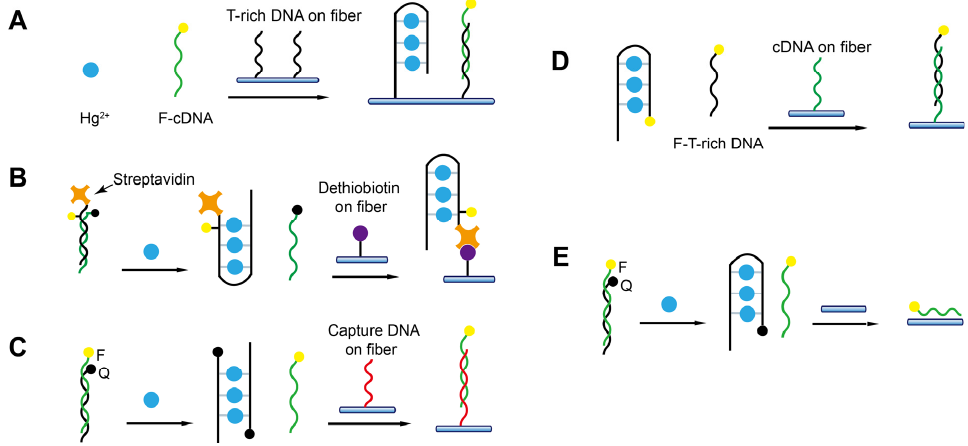
Figure 14. Schematic diagrams of T-rich probe-based FOEW sensors for Hg 2+ detection using fibers functionalized by ( A ) T-rich DNA [51]; ( B ) dethiobiotin [64]; ( C ) capture DNA [79]; ( D ) cDNA [60]; or ( E ) nothing (bare fiber) [60].